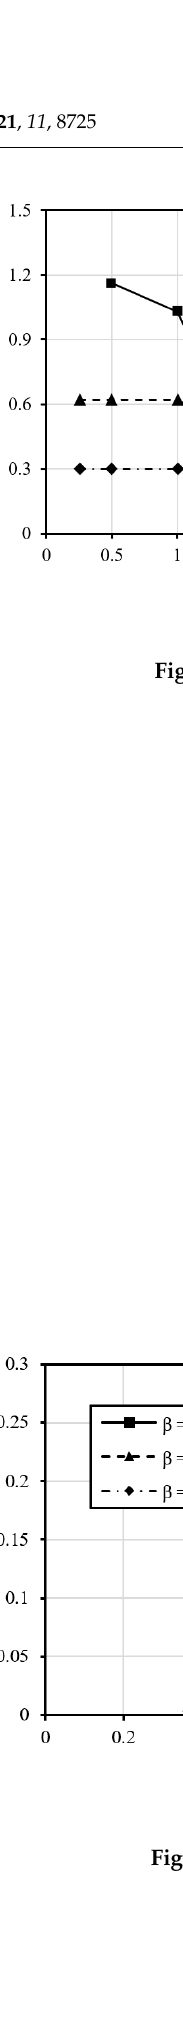
Figure 18. Variation of λ * against B / R c : ( a ) circular arch; ( b ) basket-handle arch. Table 5. Minimum statically stable B / R c.